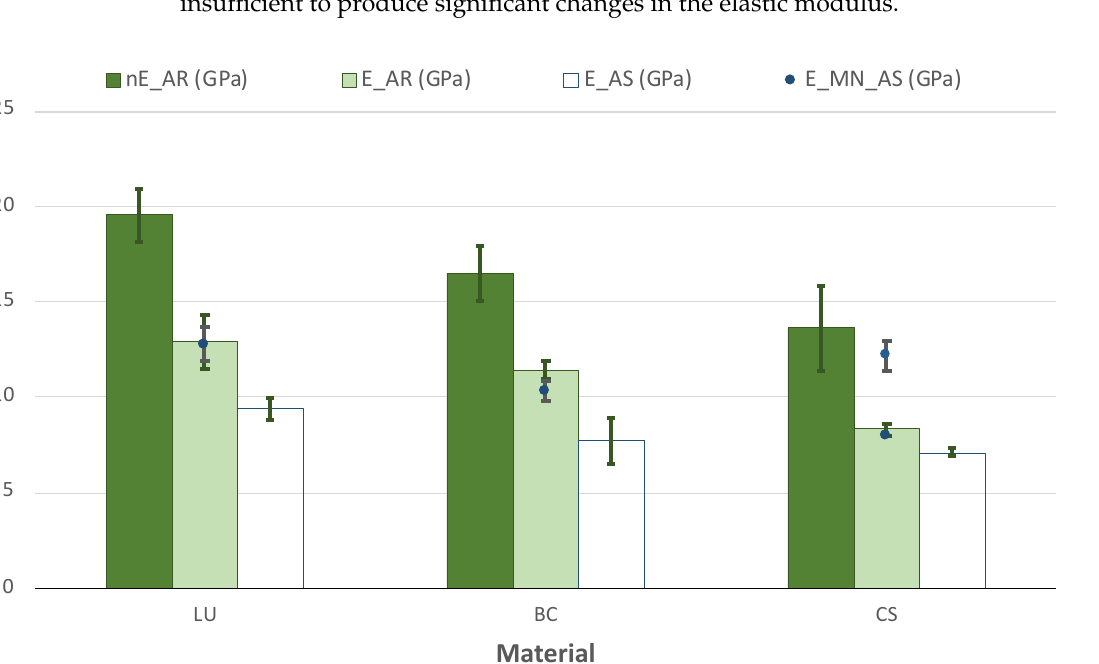
Figure 7. Nanoelastic modulus (nE) and elastic modulus (E) from TPB tests and standard error of the materials in the AR-state and after immersion in AS and compare with the MN’s data after water immersion.